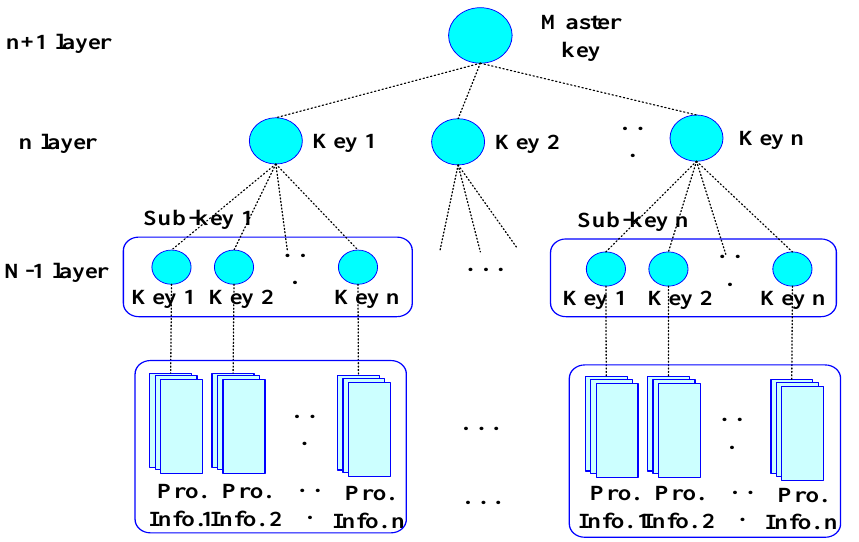
Figure 5. Process for creating subgroup keys of